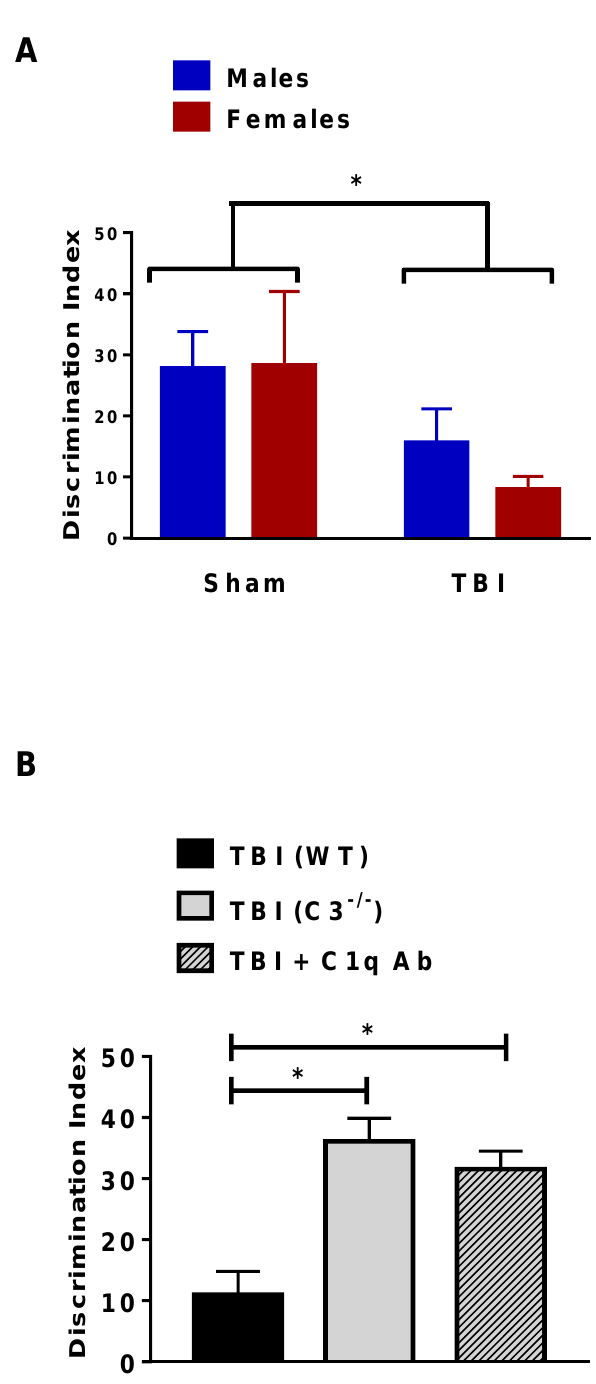
Figure 6. Complement blockade prevents memory deficits in aged animals after contusion injury. Trauma-induced memory deficits were measured by novel object recognition. Animals were exposed to two identical objects; 24 h later, the animals were exposed to one familiar object and one novel object. Memory deficits were calculated by a deficit in distinguishing the new (novel) object. ( A ) Both male and female animals displayed memory deficits following TBI (30 dpi). Two-way ANOVA revealed a significant injury effect (F = 4.42, p < 0.05); n (males) = 15–17/group; n (females) = 6–7/group. ( B ) Genetic C3 knock-out (C3 − / − ) or pharmacological (C1q-inhibiting antibody (Ab)) blockade of complement initiation factors prevents trauma-induced deficits; n (TBI wild-type) = 27 mice; n (TBI C3 − / − ) = 4 mice; n (TBI + C1q Ab) = 7 mice. One-way ANOVA revealed significant differences (F = 6.35; p < 0.01). Tukey post hoc analysis was used for differences between groups. * p <